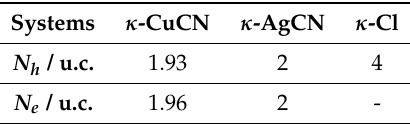
Table 7. Hole ( N h ) and electron ( N e ) occupations per unit cell of κ -CuCN, κ -AgCN, and κ -Cl, obtained from ab initio calculations with vdW interactions included via the PBE-vdW functional.